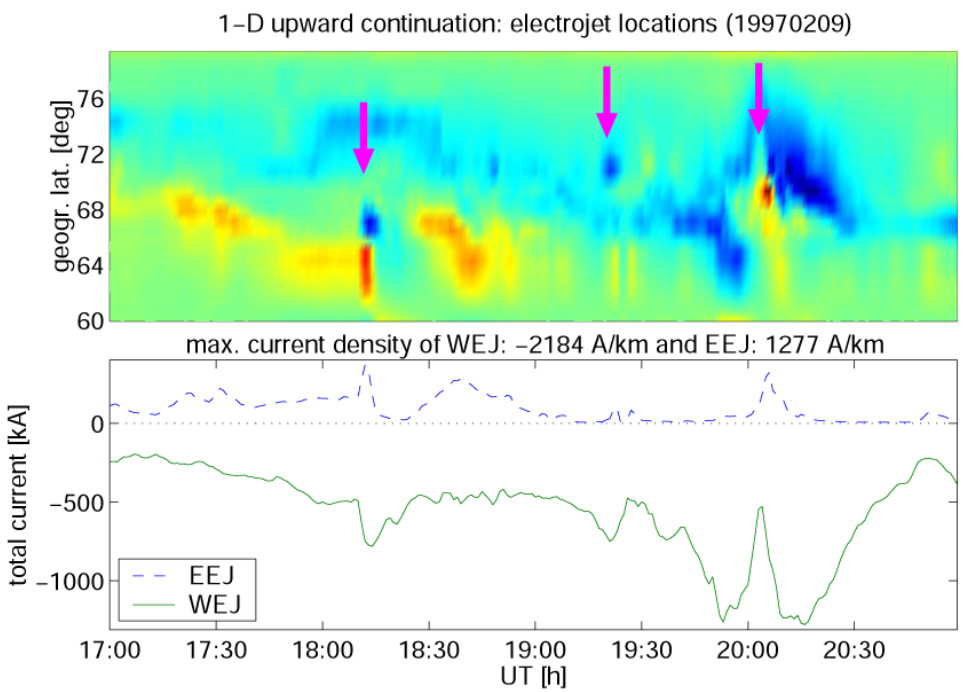
Fig. 2. The locations (in geographic latitudes) and intensities of the auroral electrojets as a function of time during the period of this study. In the top plot, the blue (red and yellow) colors show the location of the westward (eastward) electrojet (currents are close to zero in the green regions) and in the bottom plot, a solid (dashed) curve shows the total current intensity of the westward (eastward)